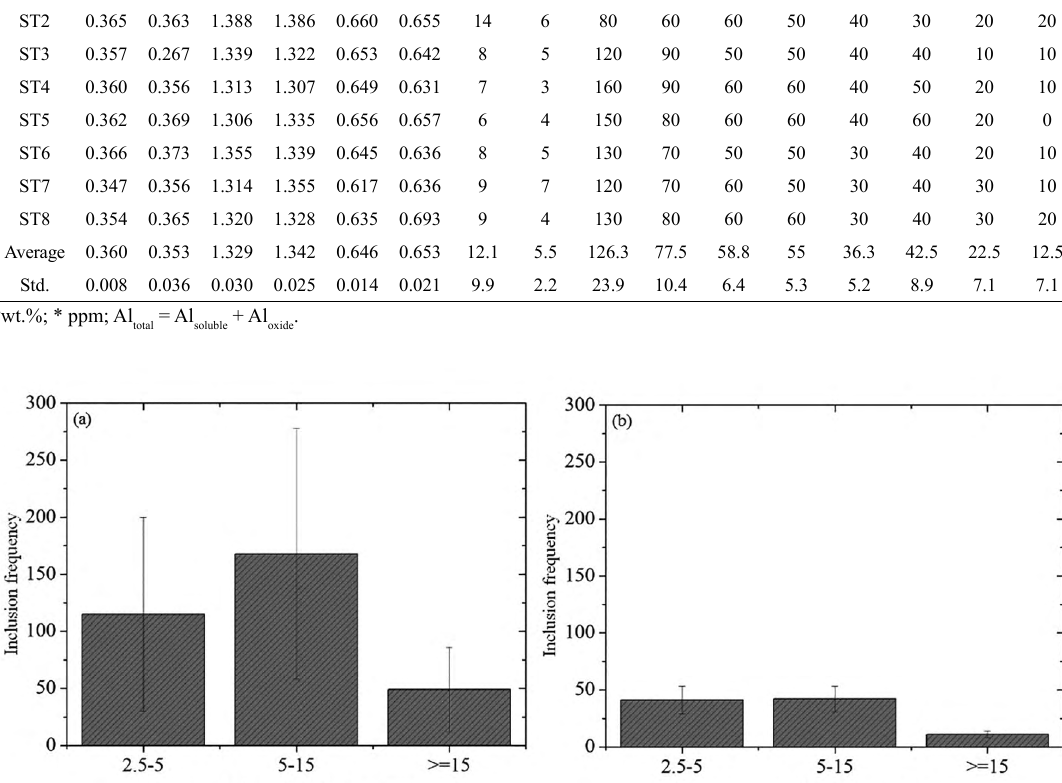
inclusions have higher rising velocity and are more